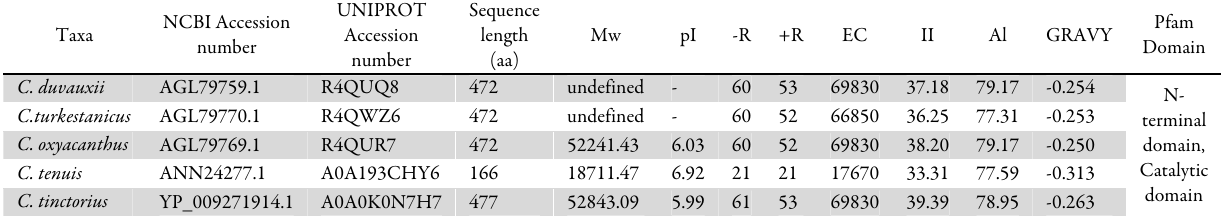
Table 1. The physiochemical properties of RuBisCO proteins from Carthamus ssp.